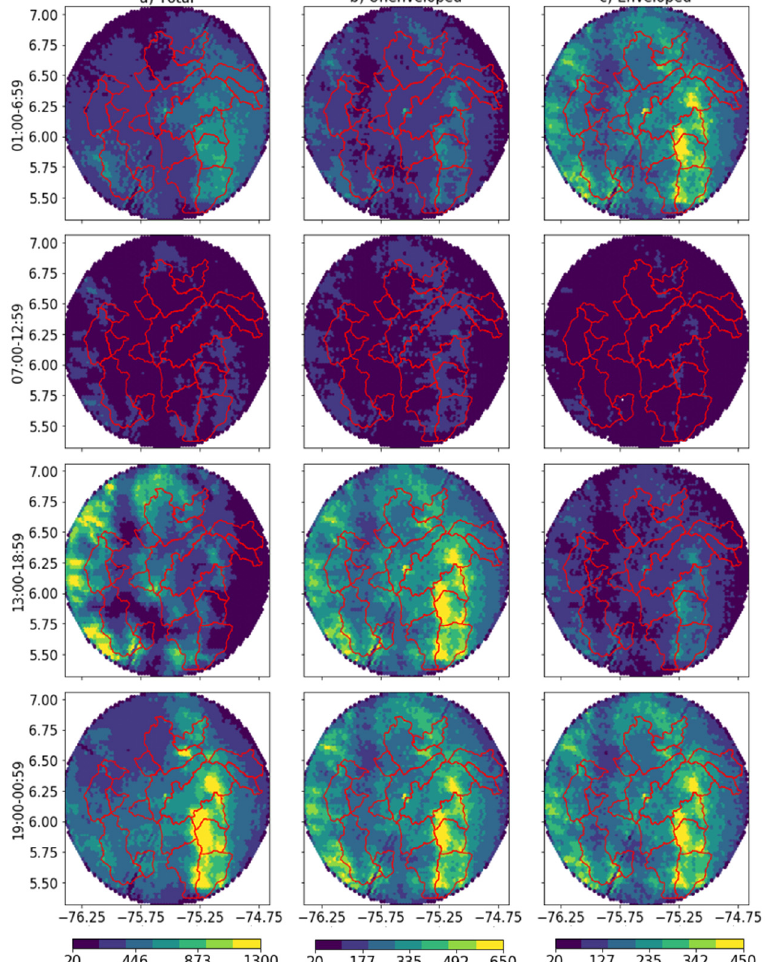
Figure 8. Two-dimensional histogram of convective centroid localization inside the radar region. Column ( a ) corresponds to total convective localization, ( b ) unenveloped systems, and ( c ) enveloped ones. The colors represent the count of elements. Color bars correspond to each of the columns.